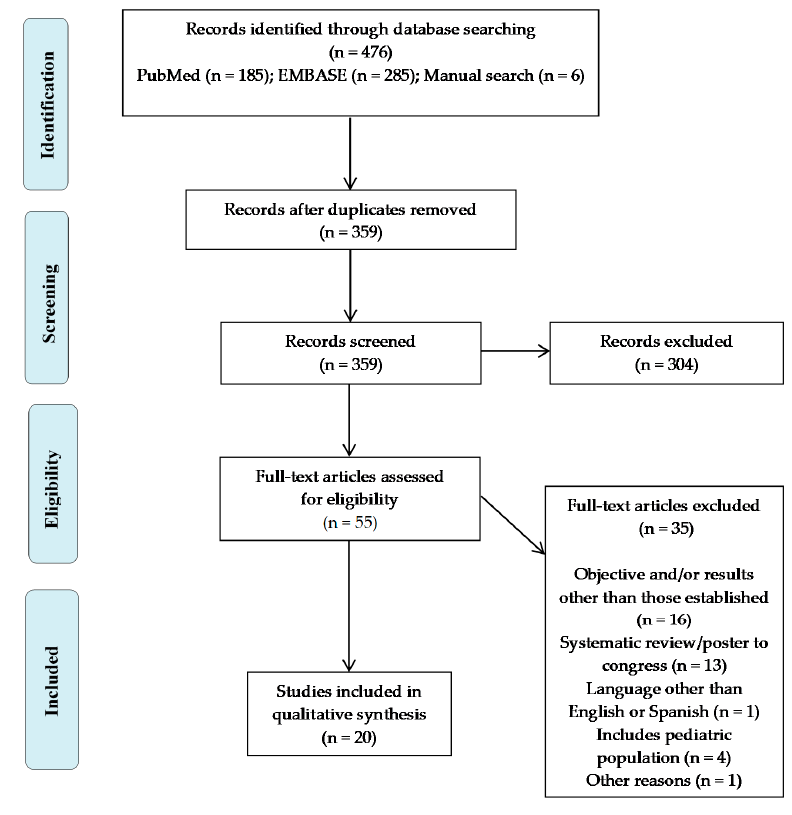
Figure 1. Study selection